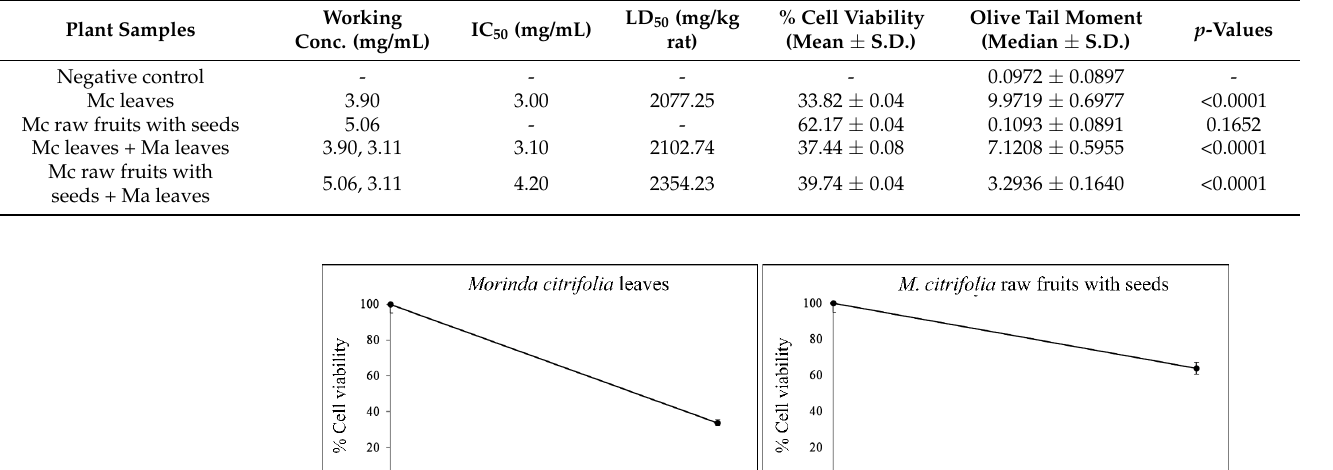
Figure 7. Cytotoxicity showing viability percentages of PBMCs treated with ethanol extracts of Morinda citrifolia leaves, M. citrifolia rawfs, M. citrifolia leaves plus Morus alba and M. citrifolia rawfs plus M. alba extracts.